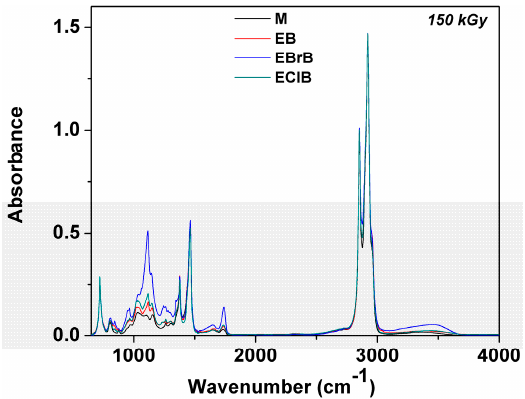
Figure 13. FTIR spectra of EPDM/butyl rubber composites irradiated at 150 kGy.